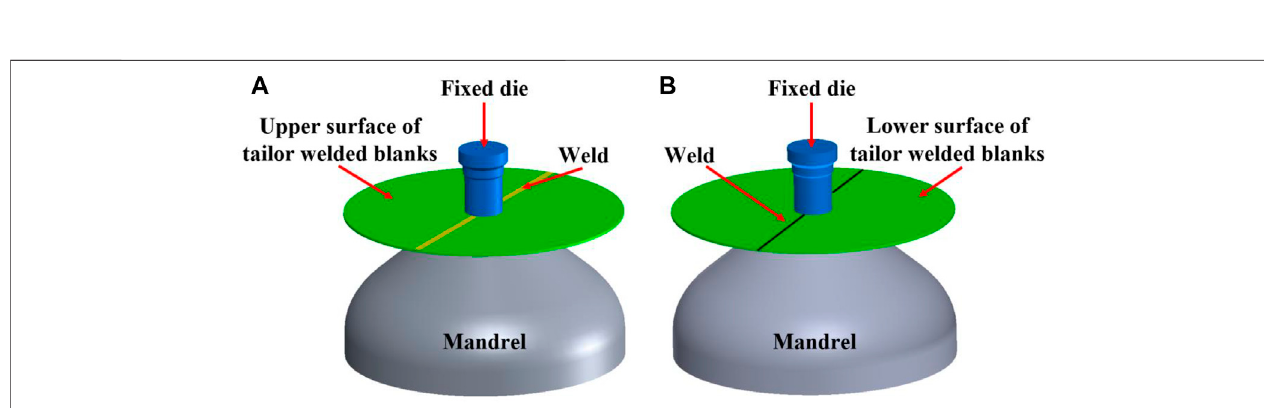
FIGURE 9 | Installation method of tailor welded blanks: (A) USTWBSR; (B) LSTWBSR.